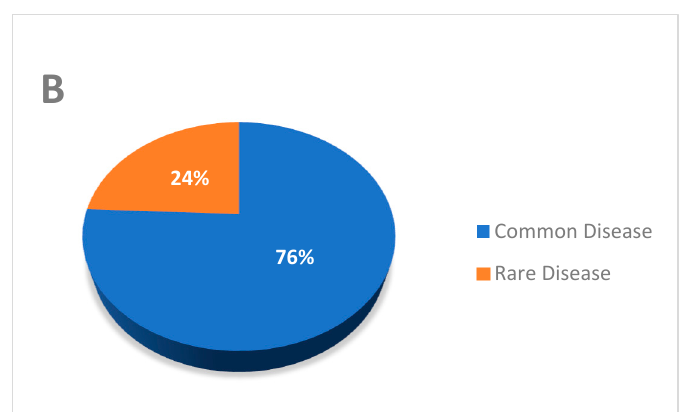
Figure 2. Published literature on modifier studies from 1998 to 2019. Keyword-based literature search result was extracted from PubMed and WoS (See Figure S1). ( A ) Histogram showing a comparative view of published literature for each year. ( B ) Pie chart showing a comparison between common and rare disease studies from 846 literature records.